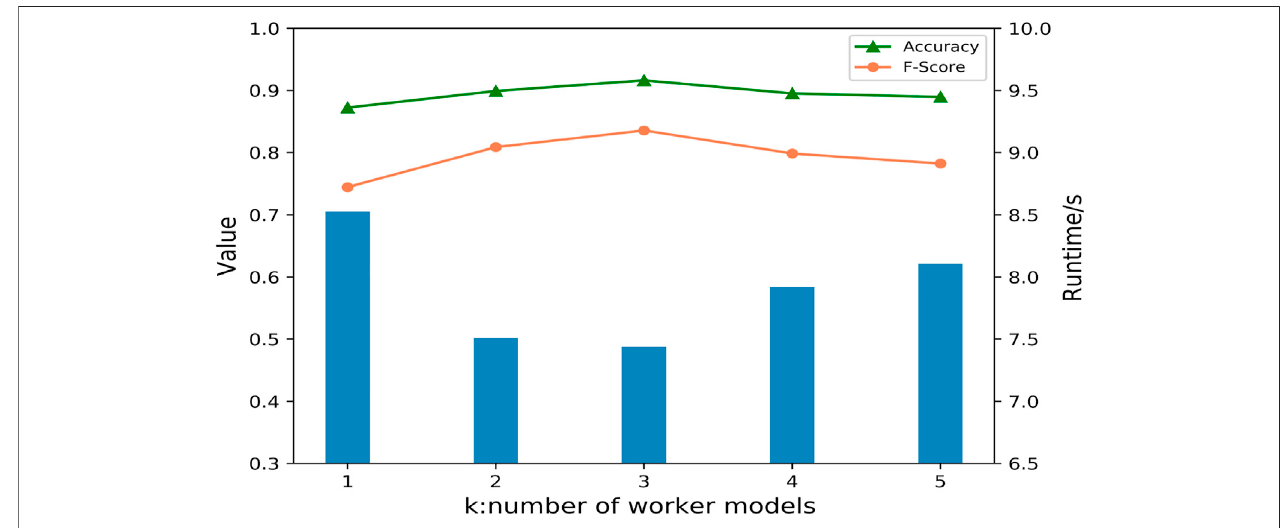
FIGURE 10 | Scalability of XFinder in distributed machine learning.